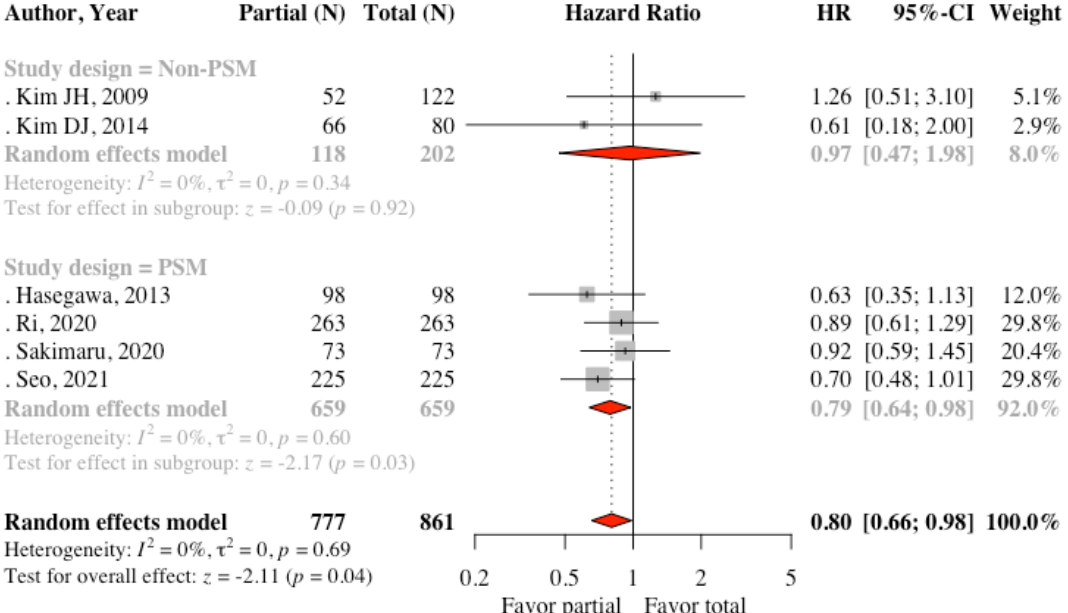
Figure 2. Forest plot comparing disease-free survival between the partial omentectomy group and the total omentectomy group.